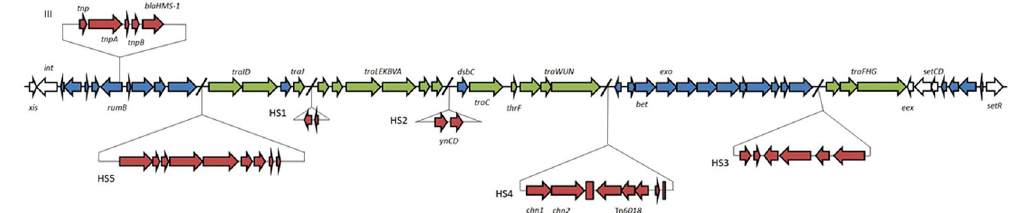
Figure 1. Molecular map of the ICE R997 showing the location of the genes associated with the 85 kb element. Genes in white are involved in R997 integration, excision and control; genes in green are involved in R997 conjugative transfer; genes in blue are involved in other R997 functions, genes in red are the accessory